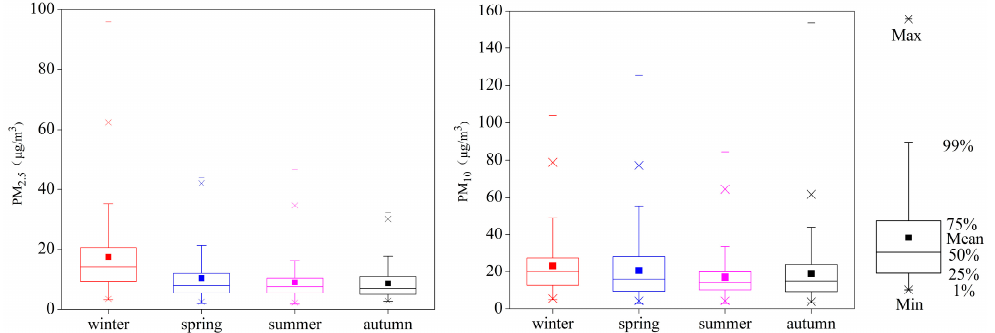
Figure 3. Seasonal variations of PM 2.5 and PM 10 during 2017–2019. The box plots show PM 2.5 and PM 10 mean values, together with the maximum, the minimum, and the 99th, 75th, 50th, 25th, and 1st percentiles.